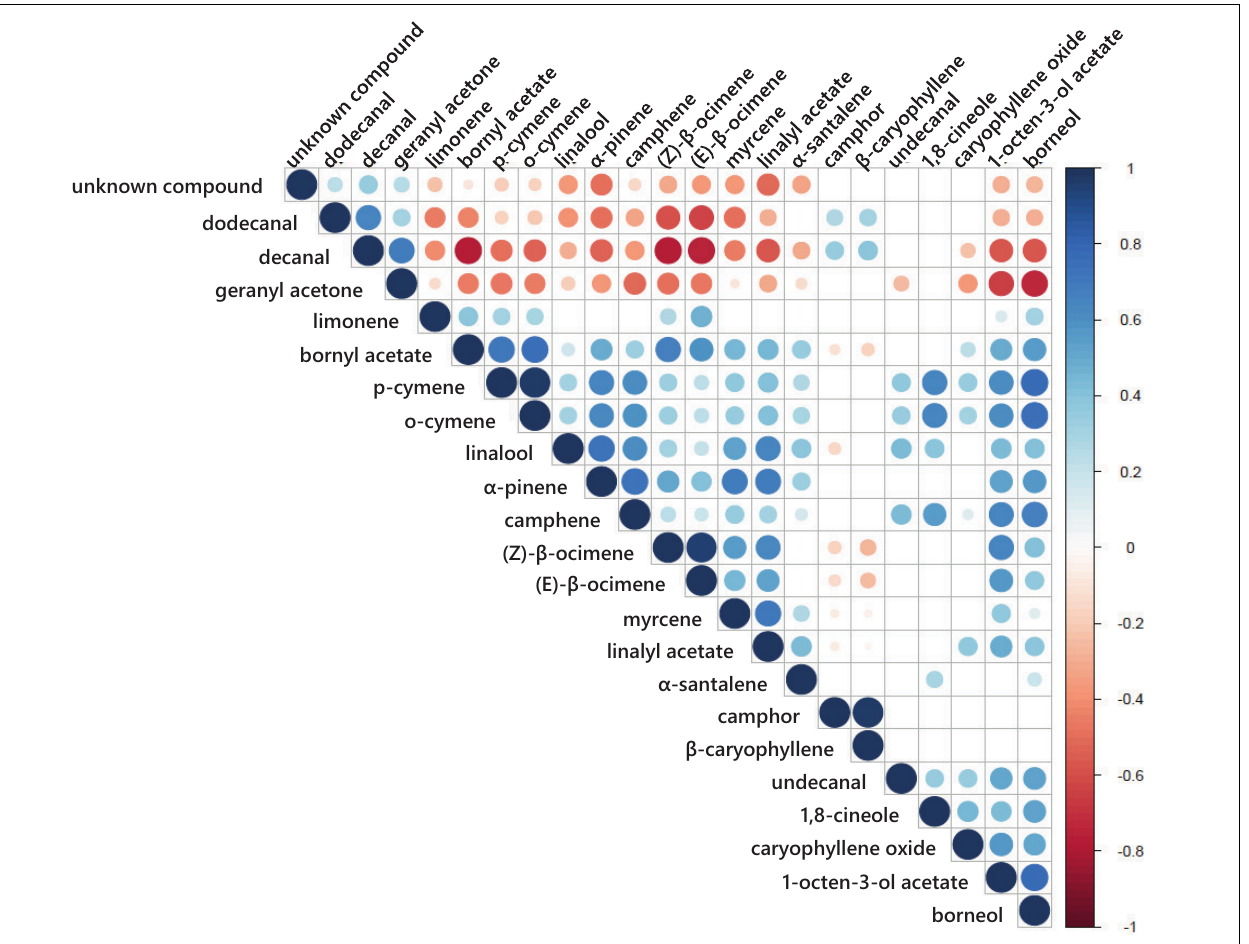
FIGURE 6 | Visualization of the pairwise correlation matrix of the concentrations-like (peak areas) of all flowering lavender compounds during volatile organic compounds (VOCs) O 3 exposure in experiment 2. Red symbols correspond to negative correlation coefficients, blue symbols correspond to positive correlation coefficients. The size of circles represents the magnitude of the value of the correlation coefficient (r). No circles means that the correlation coefficient was not significant at the threshold of 95% based on Pearson’s